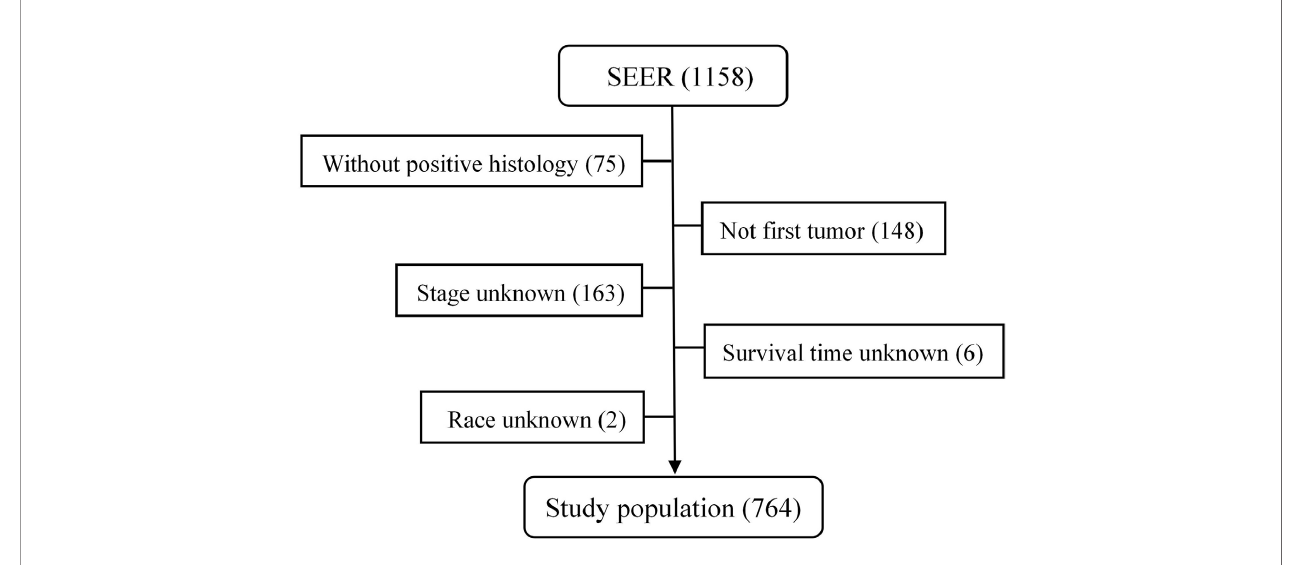
FIGURE 1 | The fl ow chart of data process in the SEER database.